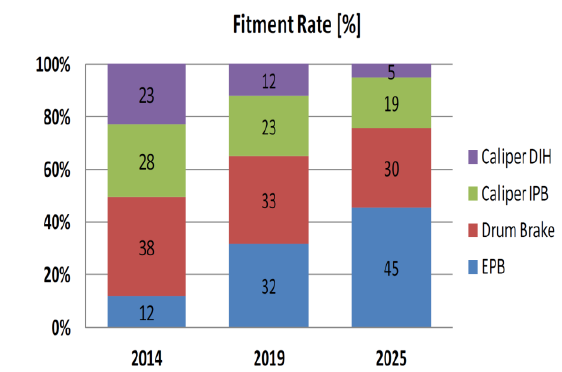
Figure 1 EPB forecasted fitment EPB fitment rate [%]